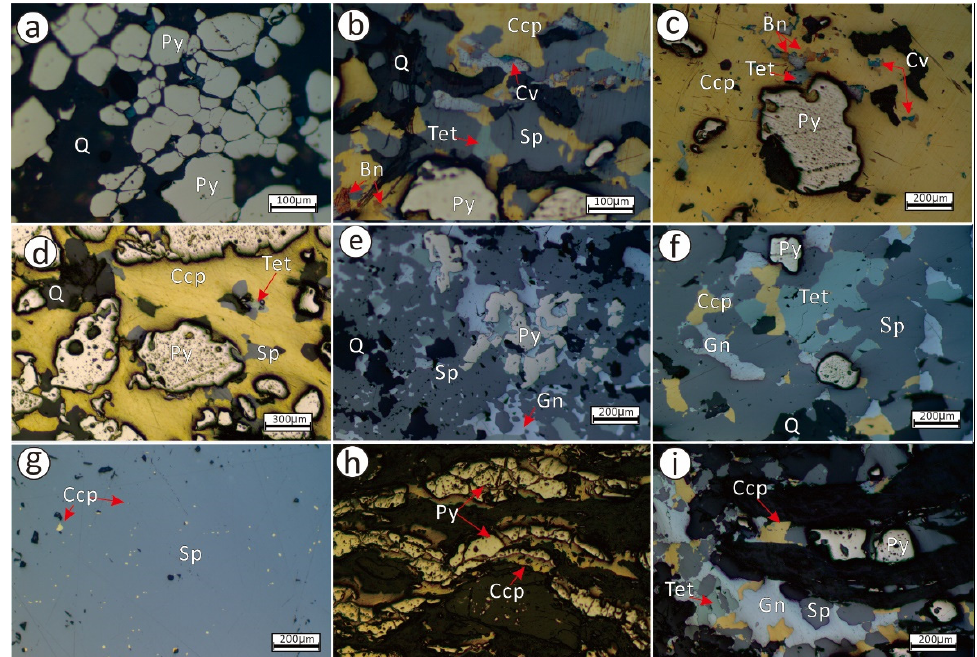
Figure 5. Photomicrographs (reflected light and transmission light) showing the representative mineral assemblages and textural features of the Xialiugou deposit. ( a ) Subhedral crystals in pyrite aggregates. ( b ) The intergrowths of chalcopyrite, tennantite, sphalerite, covellite and bornite that partly replace the subhedral pyrite. ( c ) Pyrite was replaced by chalcopyrite and tennantite as subhedral grains. ( d ) Subhedral pyrite was replaced by chalcopyrite, tennantite and sphalerite. ( e ) The intergrowth of galena and sphalerite partly replaced the subhedral pyrite. ( f ) The intergrowths of galena, sphalerite, chalcopyrite, tennantite, partly surrounded the subhedral pyrite. ( g ) Chalcopyrite coexisting with sphalerite in the form of disease texture. ( h ) Cataclastic texture of pyrite grains sealed by chalcopyrite. ( i ) Pyrite is sealed by ductile minerals of chalcopyrite, galena, tennantite and / or sphalerite. Py = pyrite; Ccp = chalcopyrite; Sp = sphalerite; Tet = tennantite; Bn = bornite; Cv = covellite; Gn = galena; Q = quartz.